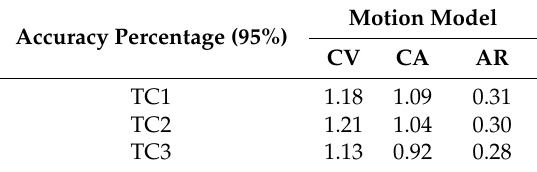
Table 4. The position fixes results for different motion models.